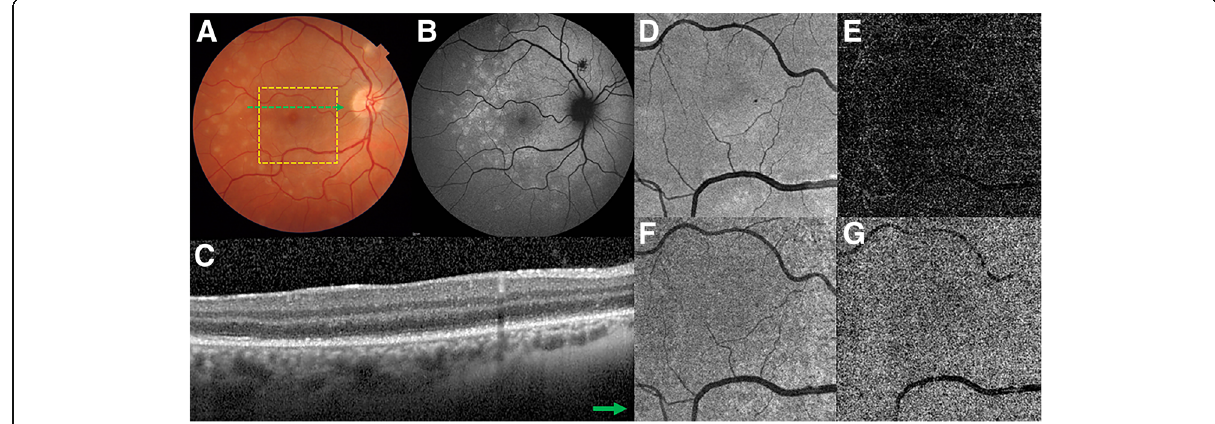
Fig. 2 Case #2. Multimodal imaging of a 33-year-old woman with MEWDS. a Color fundus imaging shows discrete white lesions in the macular area. b FAF depicts a peripapillary hyperautofluorescent area associated with widespread hyperautofluorescent lesions in the retinal fundus. c Cross-sectional OCT (represented by the green line in image a ) shows disruption of the EZ. d En-face OCT at the level of the outer retina shows an intrinsic lower reflectivity correspondent to the diffuse attenuation due to the EZ disruption on cross-sectional OCT. e – g OCTA of outer retina ( e ), en-face OCT at the level of choriocapillaris ( f ), and OCTA of choriocapillaris ( g ) demonstrate homogeneous reflectivity without artifacts or any other